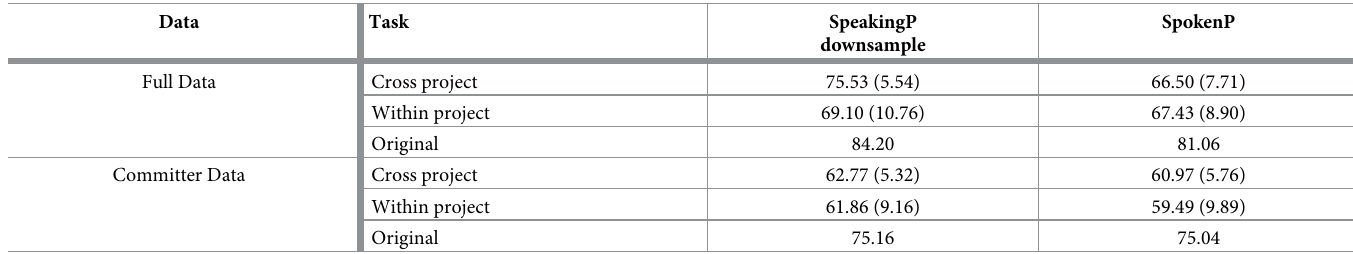
Table 3. Project-level validation for both